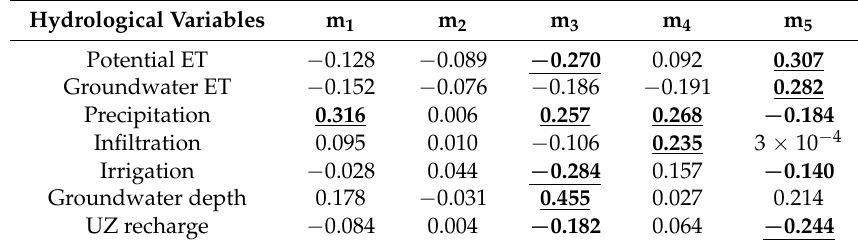
Table 5. Spearman’s rank correlation coefficients between hydrological variables and membership probabilities